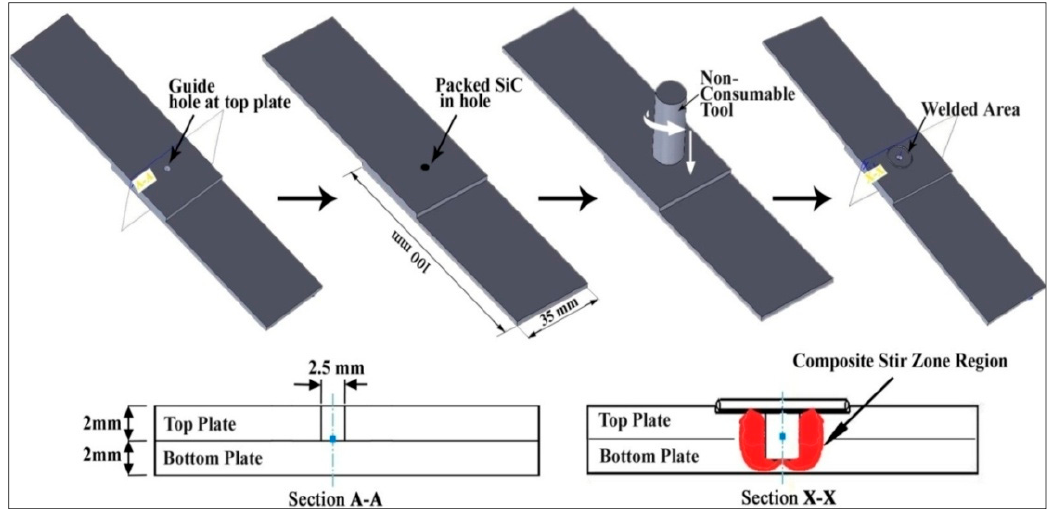
Figure 2. Sequence of the steps of the FSSW process adopted in the present research.